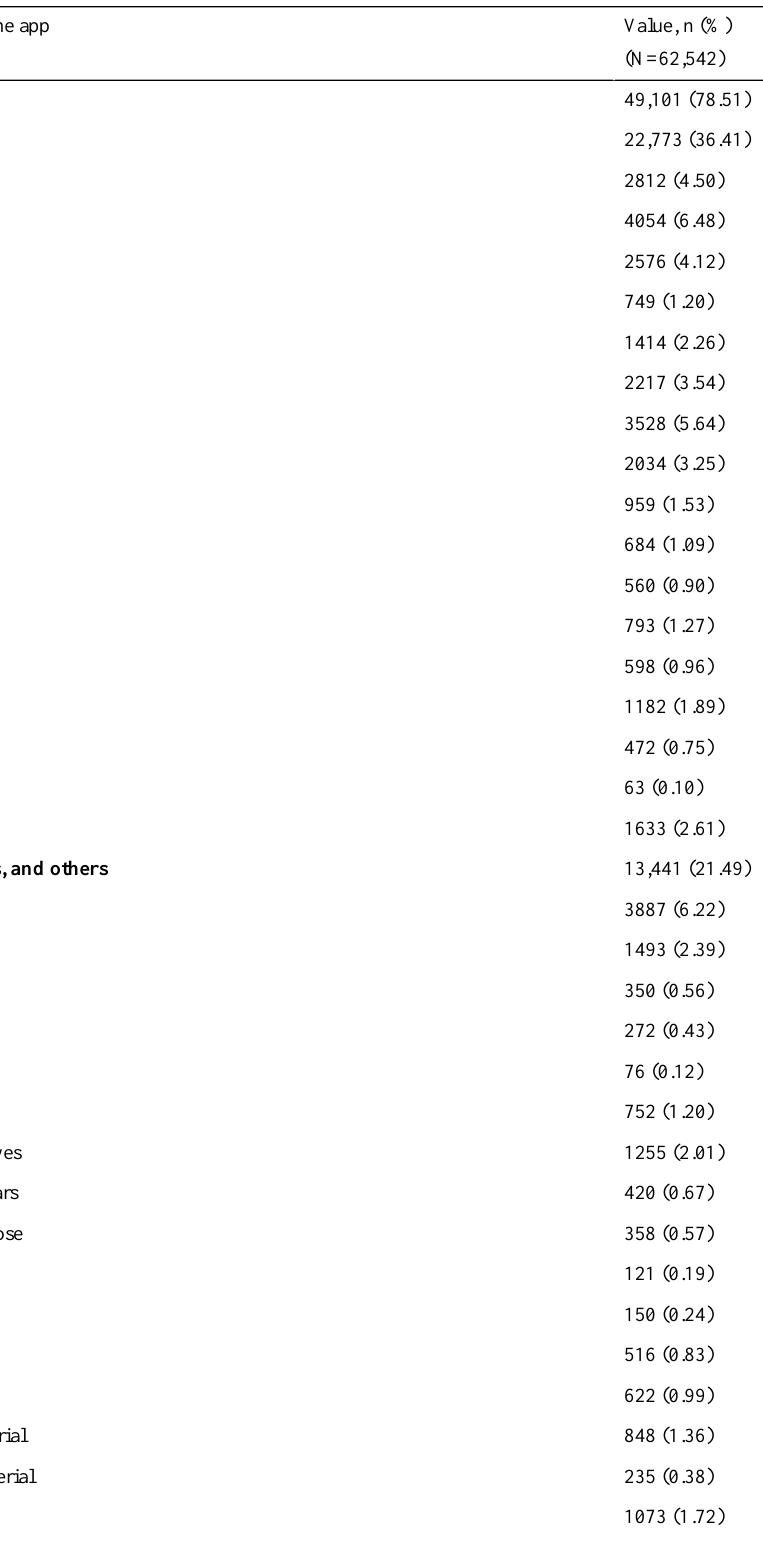
Table 2. Clinical